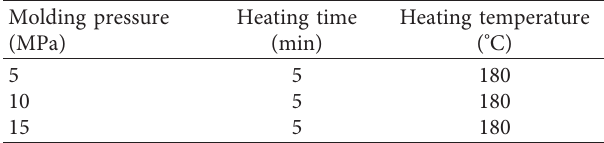
Table 2: Stepwise heating and mold pressing of the sample. Molding pressure